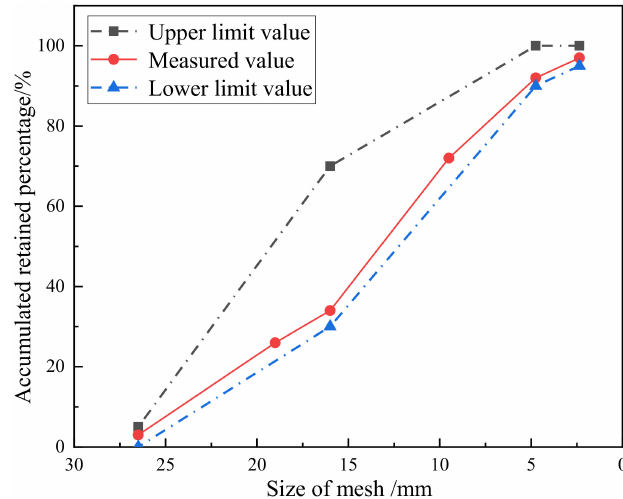
Figure 1. Sieving curve of recycled aggregate. Table 2. Properties of aggregate.